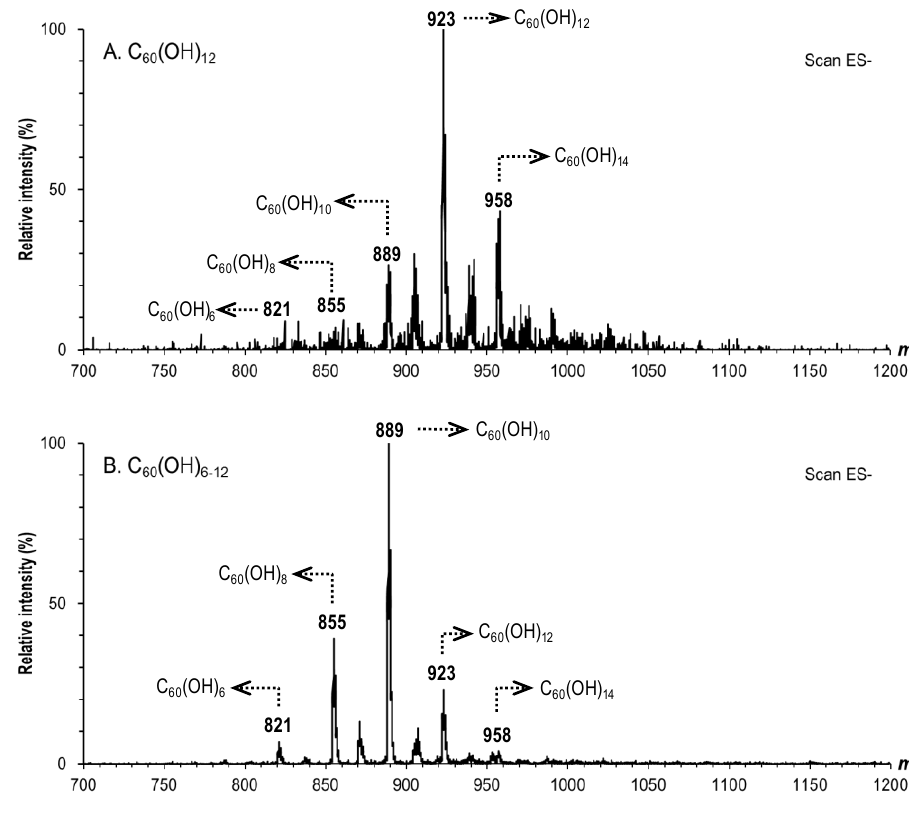
(OH) and C (OH) 60 12 60 6–12